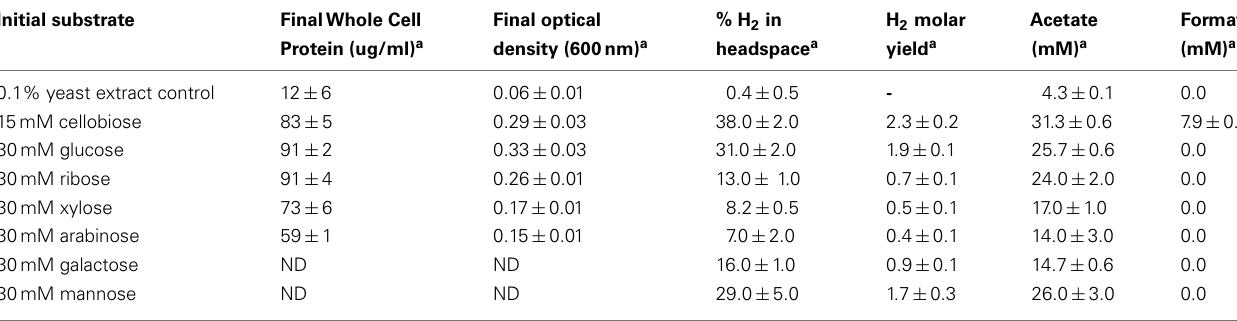
Table 1 | Growth, metabolism and hydrogen production during non-shaking, uncontrolled batch cultivation. Initial